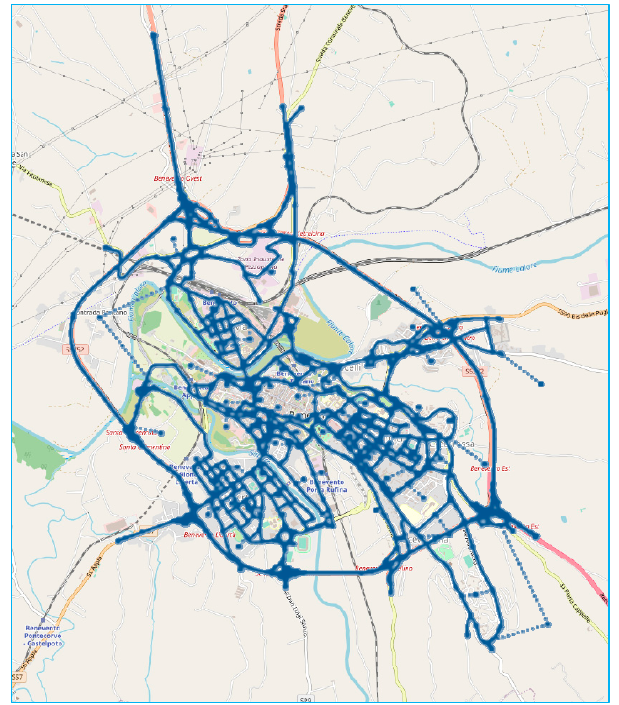
Figure 4. Urban real-scale